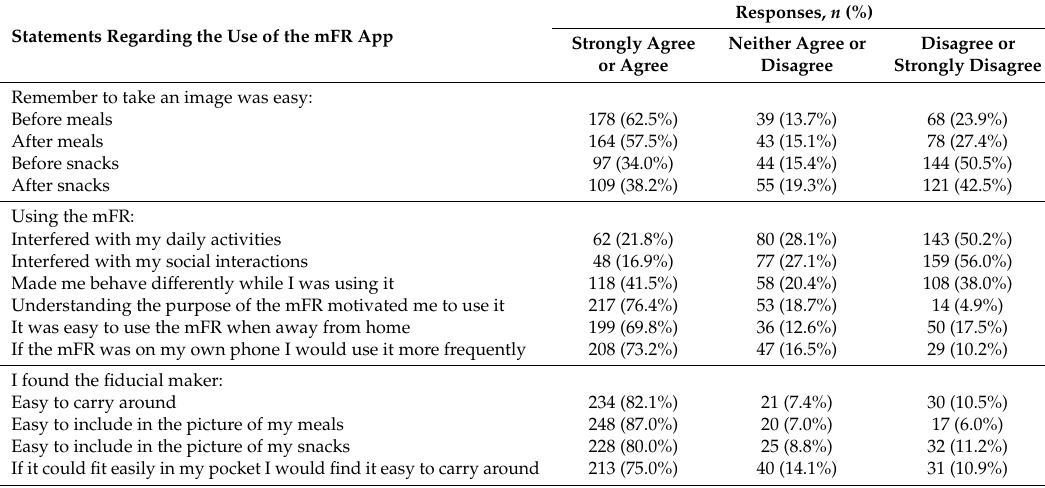
Table 2. Comparison of perceptions for adults ( n = 285) regarding the use of the mobile food record (mFR) app for 4